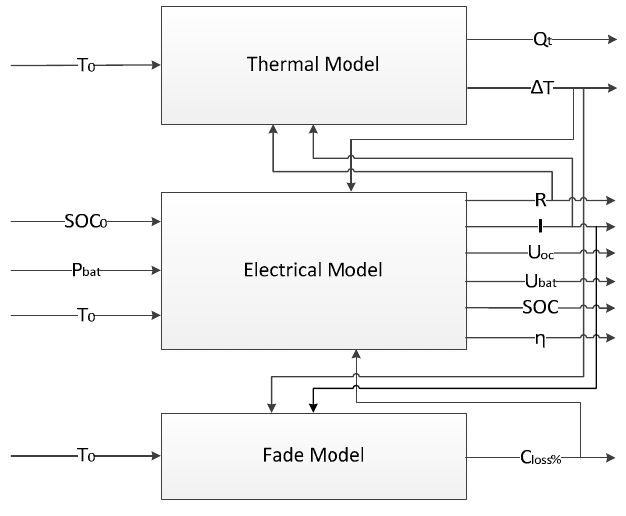
Figure 7. Coupled battery model.